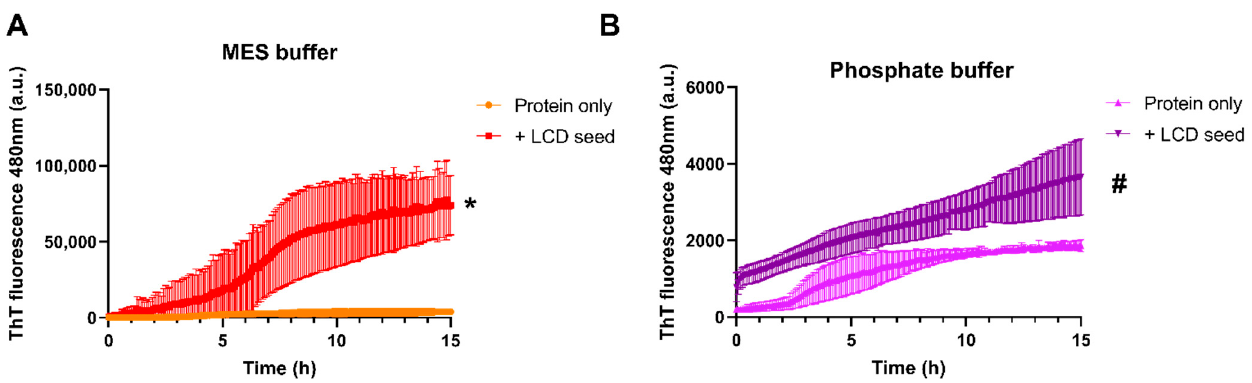
Figure 3. Detection of seeding in LLPS and non-LLPS promoting conditions. ThT fluorescence measurements as a function of time used to determine the aggregation speed of 20 µ M TDP-43 LCD. Mean ± SD shown for n = 3 independent experiments. ( A ) +/ − TDP-43 LCD seed added at 1:20 molar ratio to fresh TDP-43 LCD protein in MES buffer (LLPS-). ( B ) +/ − TDP-43 LCD seed added at 1:20 molar ratio to fresh TDP-43 LCD protein in phosphate buffer (LLPS+). Y-axis scale for both graphs is different to allow for visualization of seeding effect. For both ( A , B ) conditions, the increase in ThT fluorescence was followed over time and compared with the condition without the seeds. Protein only is protein in corresponding buffers with no additional LCD seeds. Sedimentation assays conducted for * and # end-point where mixture included seeds. There was approximately 12% more soluble protein left in the LLPS+ condition (phosphate buffer) as is shown in Figure S3.